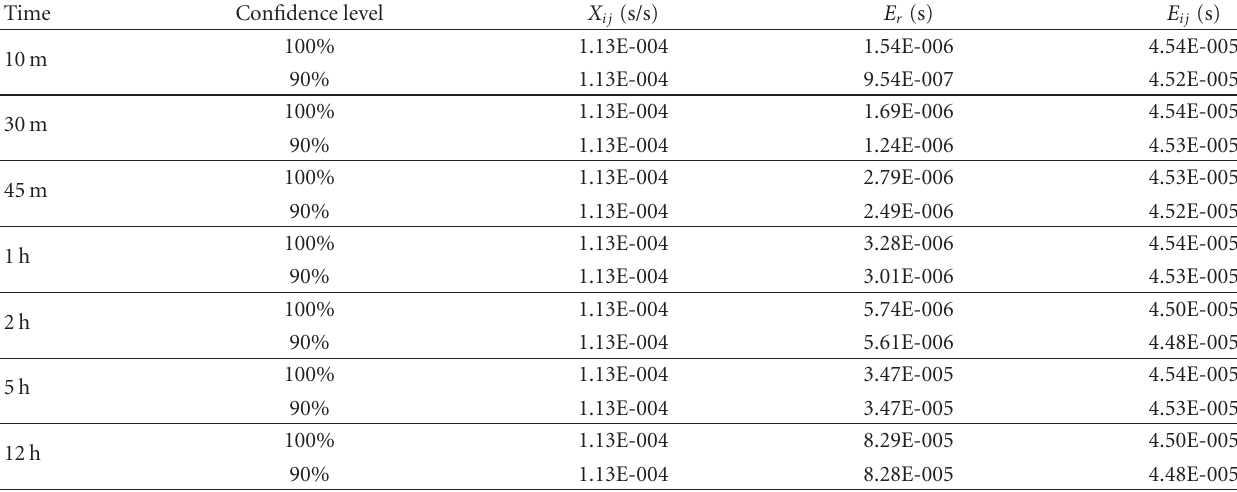
Table 4: Clock drift approximation according to several di ff erent duration.